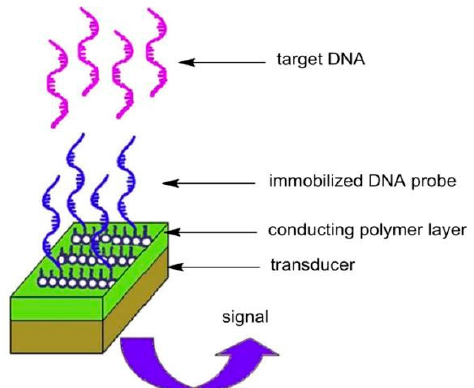
Figure 18. Basic design of a DNA sensor based on a conducting polymer [86]. Reprinted